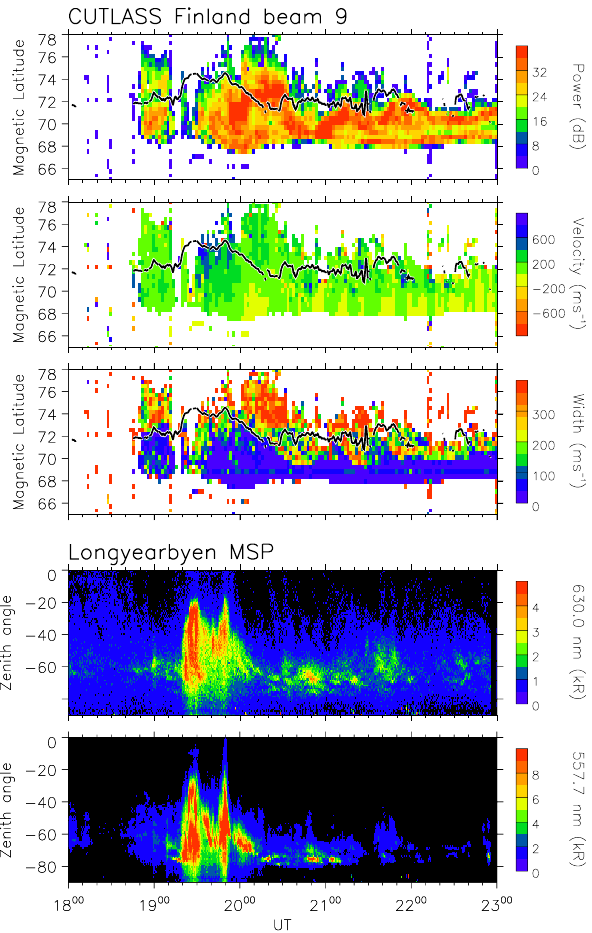
Fig. 4. Backscatter power, line of sight velocity and spectral width from beam 9 of CUTLASS Finland, as a function of latitude for the interval 18–23 UT on 27 November 1997. Also plotted are the 630.0 nm emission intensity and the 557.7 nm emission intensity as a function of zenith angle from 0 ◦ to − 90 ◦ for the same interval. The full line marked on each panel of the radar data represents the poleward 1.5 kR contour of the 630.0 nm emission (see text for full discussion).